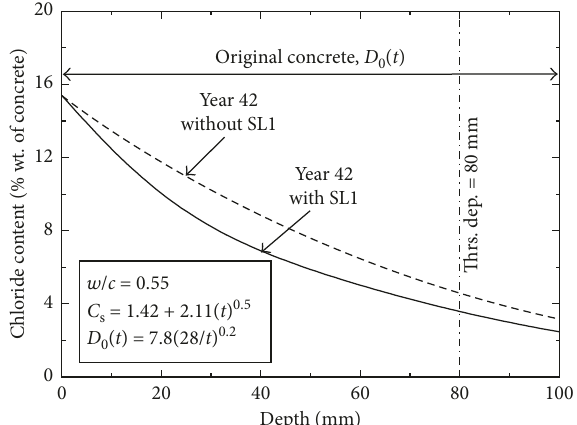
Figure 6: Chloride content versus depth for concrete without and with SL1 at year 42.